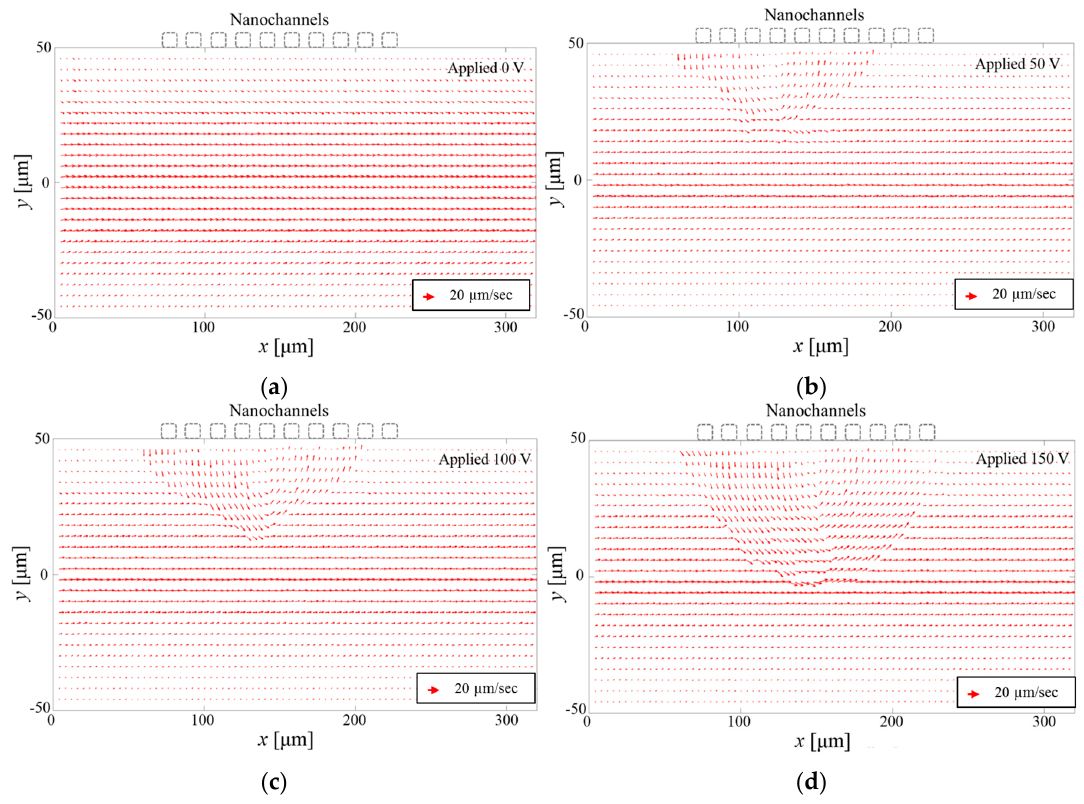
Figure 3. Velocity field particle tracking with ( a ) no applied voltage; ( b ) 50 V; ( c ) 100 V; and ( d ) 150 V.